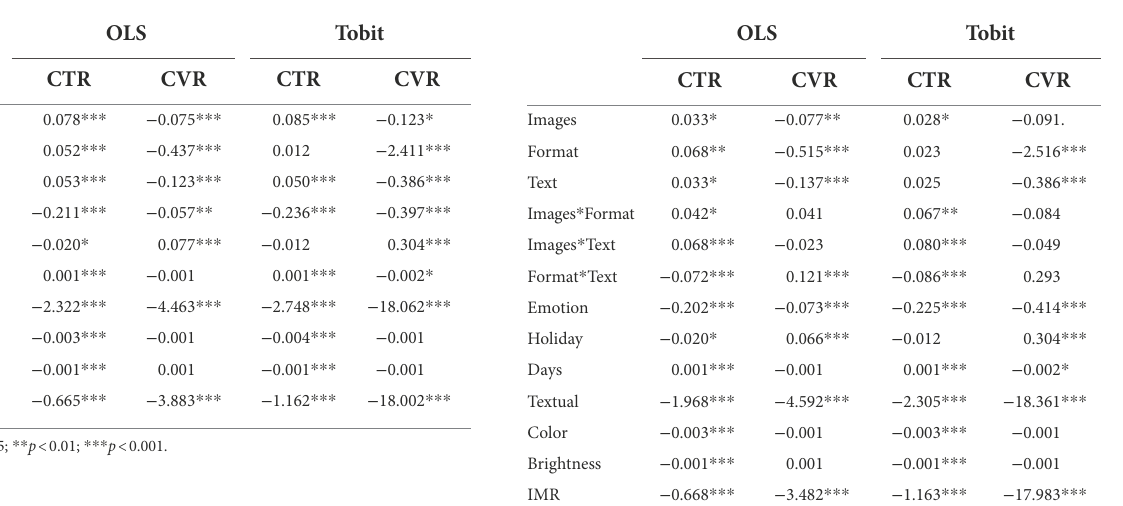
TABLE 5 Main effects results. TABLE 6 Interaction